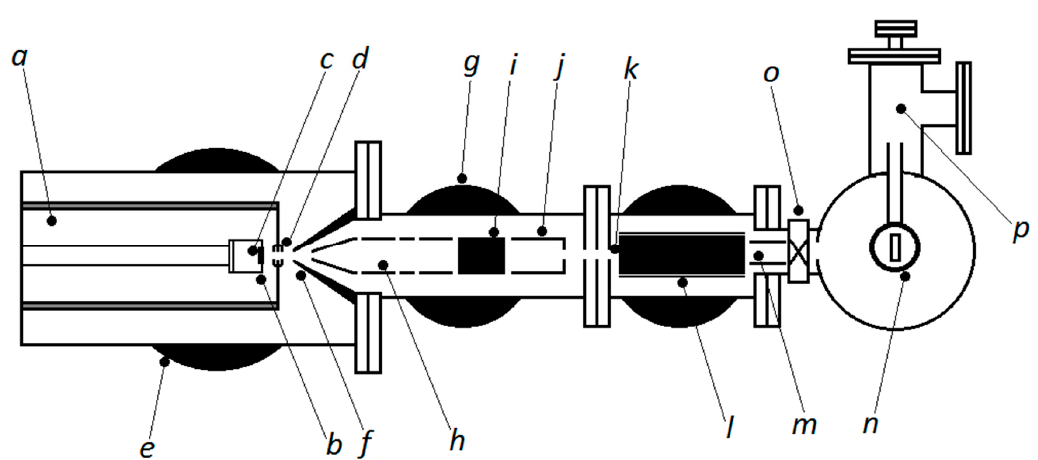
Figure 1. Scheme of the cluster source, showing ( a ) condensation chamber; ( b ) magnetron sputtering head; ( c ) metal target; ( d ) nozzle; ( e ) turbo pump; ( f ) skimmer; ( g ) turbo pump; ( h ) acceleration and focus lens, ( i ) X-Y deflector; ( j ) second focus lens; ( k ) entrance of the mass filter; ( l ) high transmission mass spectrometer; ( m ) set of einzel lens; ( n ) holder sample; ( o ) gate valve; ( p ) transfer chamber.